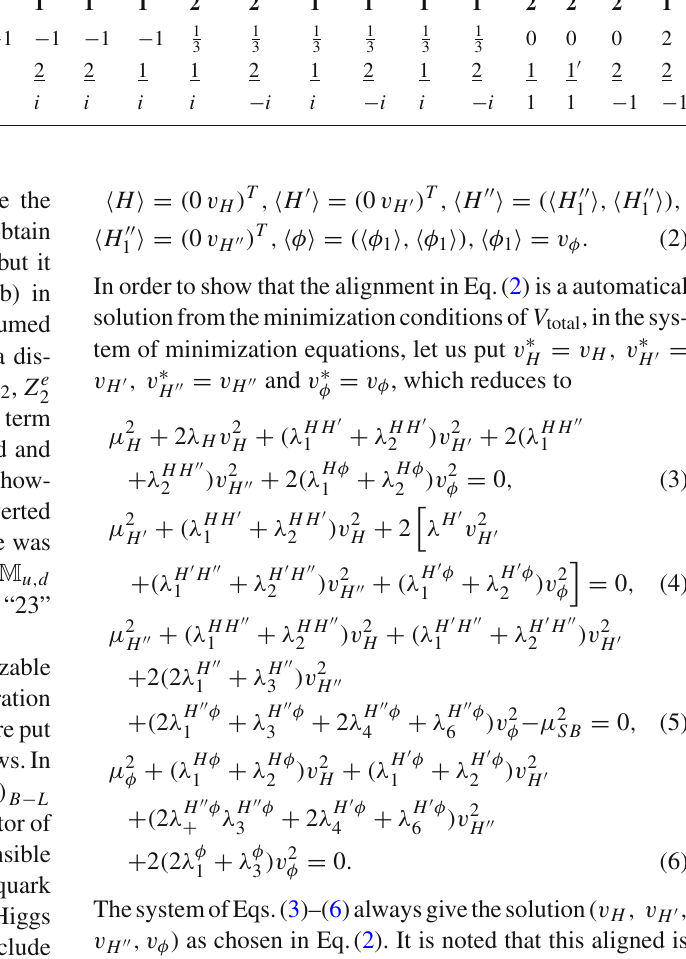
Table 1 Fermion and scalar contents of the model and the charge assignment ( α = 2 ,